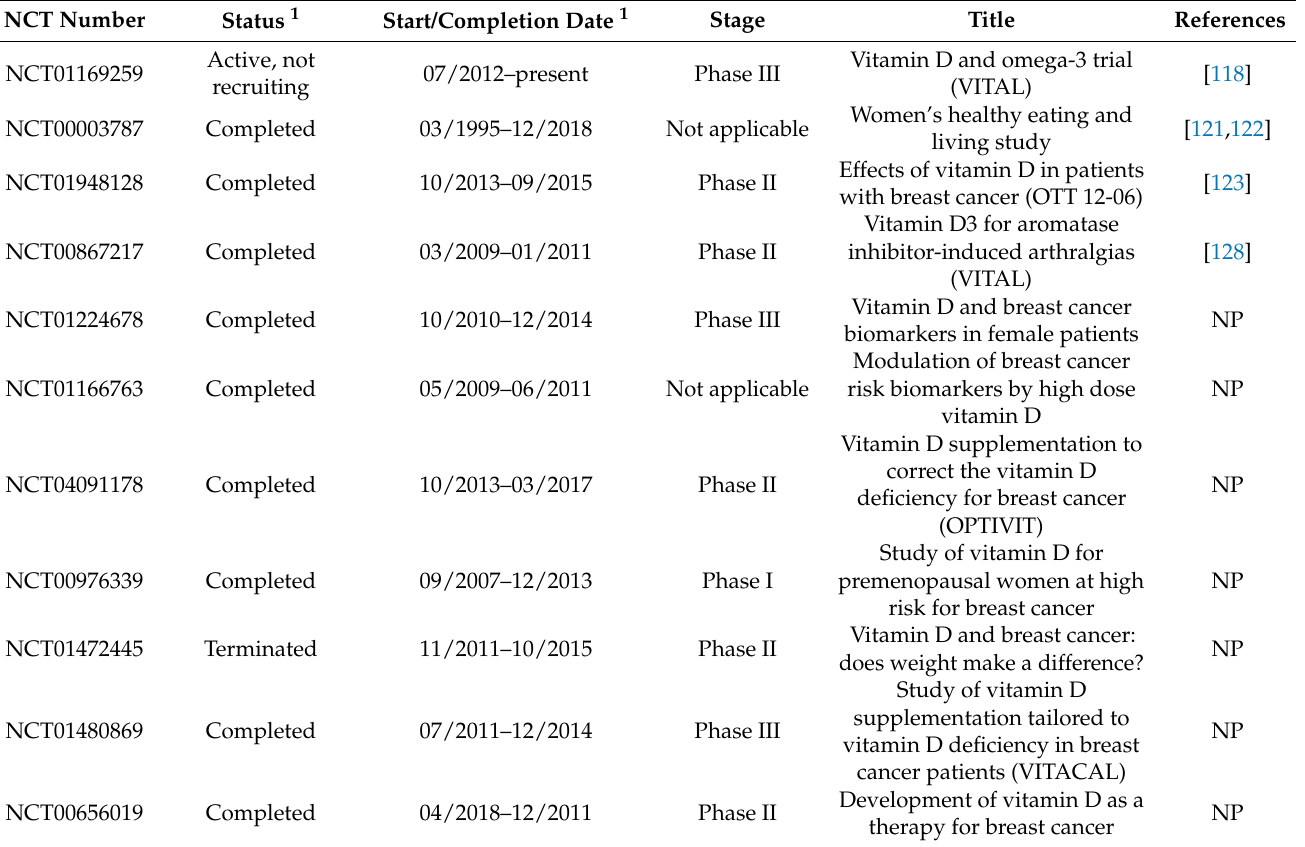
Table 6. Clinical trials with vitamin D in breast